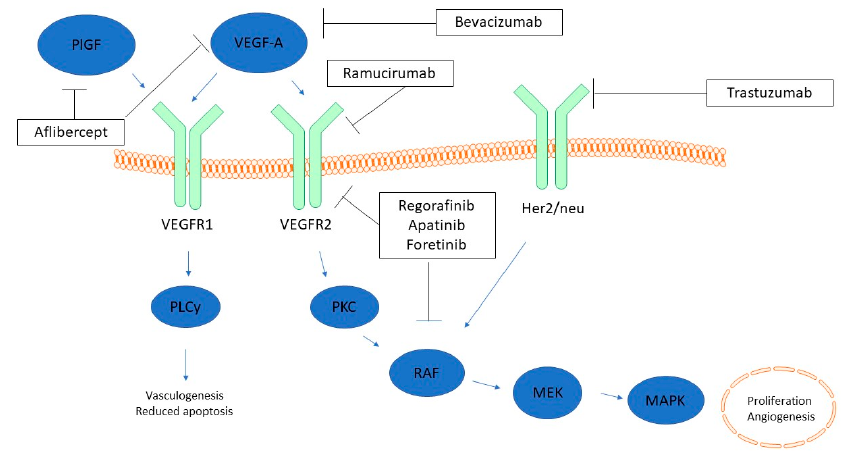
Figure 1. VEGF receptor signaling and targets of anti-angiogenic therapy (modified). PlGF and VEGF-A act through VEGFR1 while VEGFR2 is only stimulated by VEGF-A. Inhibitors of the pathways are shown in boxes. Downstream pathways are simplified for better orientation. PlGF = Placental growth factor; VEGF = Vascular endothelial growth factor; VEGFR = Vascular endothelial growth factor receptor; Her2/neu = human epidermal growth factor receptor 2; PLCy = Phospolipase C y; PKC = protein kinase C; RAF = Rapidly accelerated sarcoma kinase; MEK (MAPKK) = Mitogen-acitvated protein kinase kinase; MAPK = mitogen-activated protein kinase. Blue arrow = activation; black T-bar arrow =